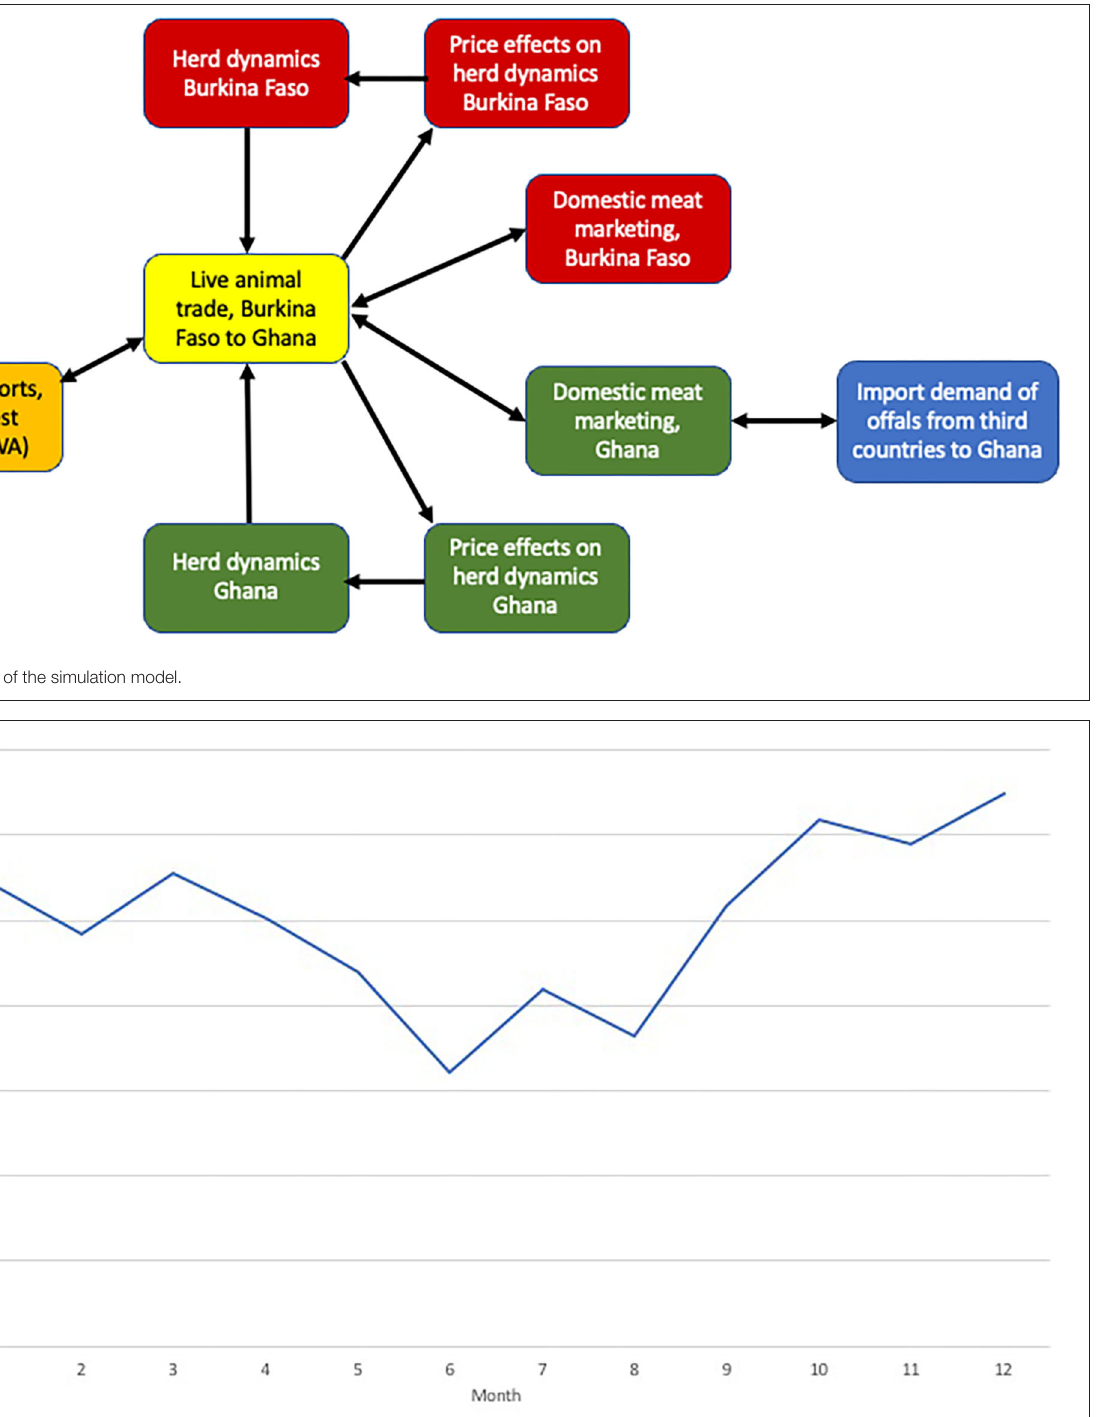
transmitted to the model’s live animal supply and derived animal demand (marginal cost of meat) functions which then (in the next period) determine a new set of inventory relationships that set subsequent prices (16,